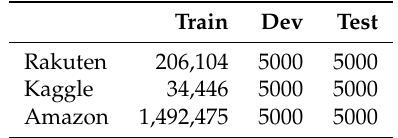
Table 1. Statistics of the experimental datasets.